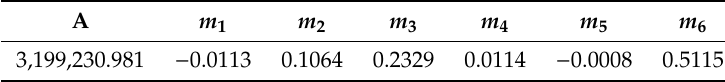
Table 3. Material parameters obtained by the traditional